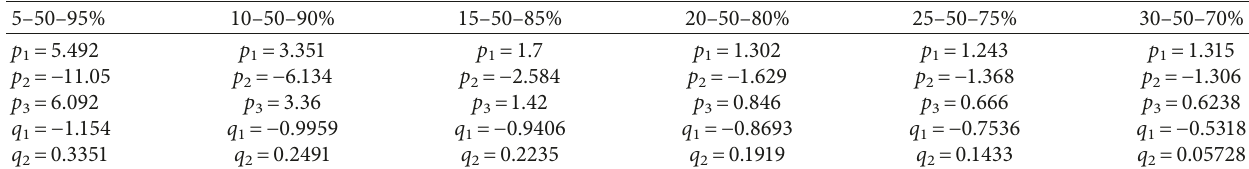
Figure 7: Data sets { α , ( τ Table 9: Parameters { p